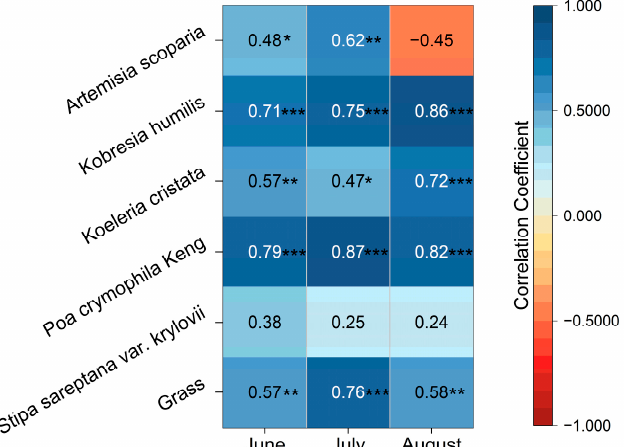
Figure 8. Correlations between multi-species AGB and effective precipitation during crucial periods. The *, **, and *** denote correlation required for significance at the 90%, 95%, and 99% levels, respectively.